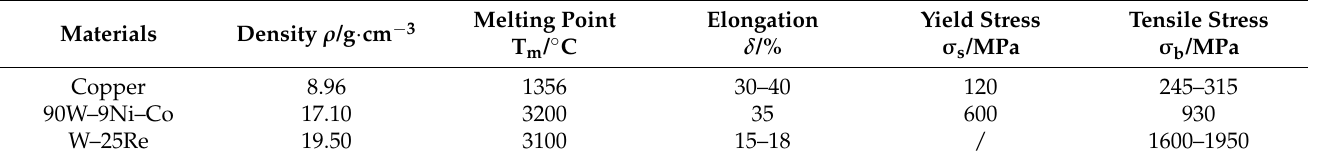
Table 1. Parameters of three kinds of metal materials for EFP liner.